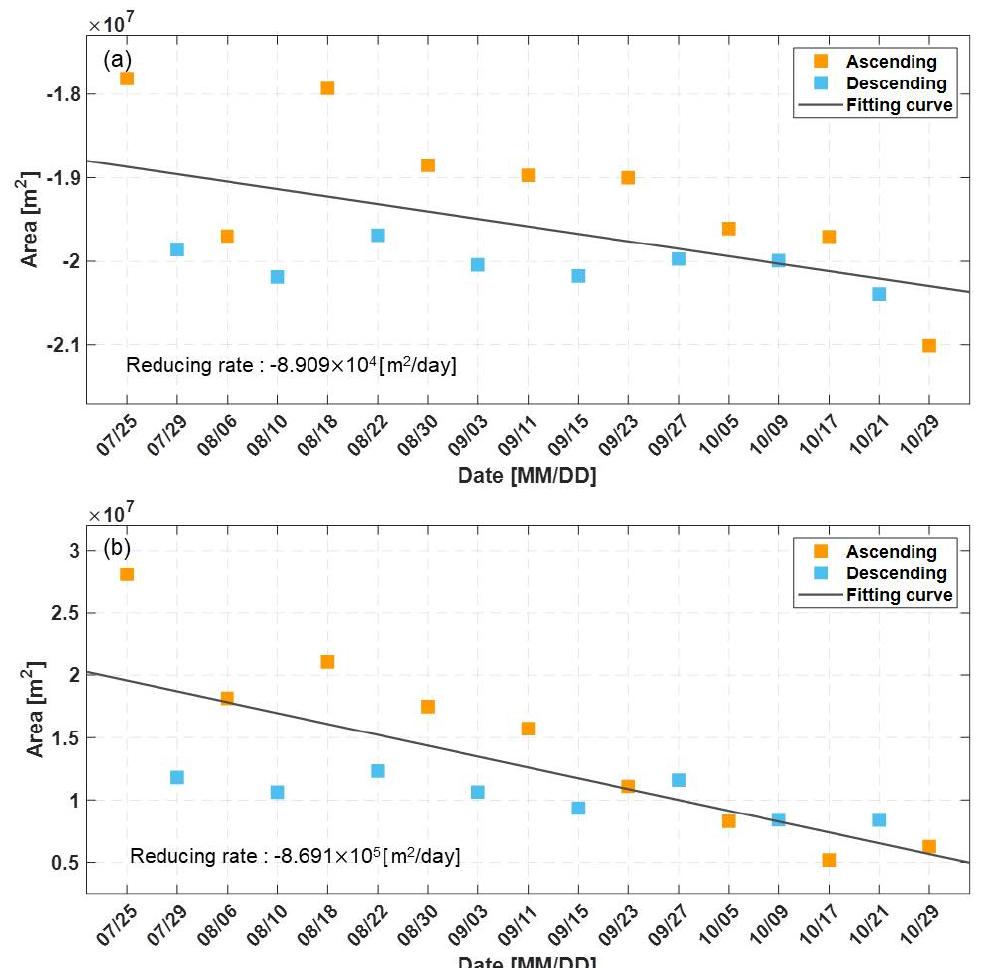
Figure 7 . Two graphs showing gradual decreases in ( a ) the water area at the Xe-Namnoy reservoir, and ( b ) the area of flooding in the Hinlat region.